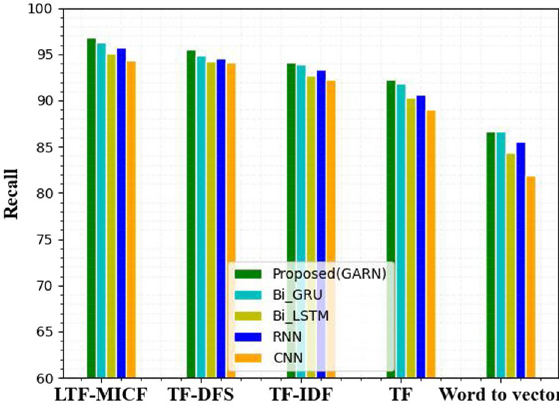
Fig. 7 Recall of the classifiers with term weight schemes